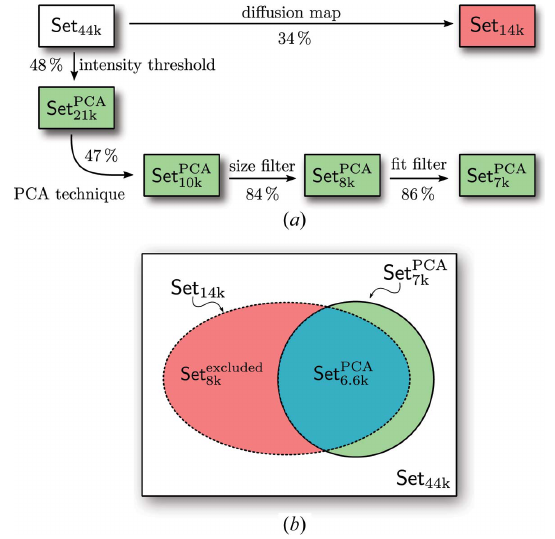
Figure 6 ( a ) Data workflow and filtering stages. The red box indicates the data selection provided by Reddy et al. (2017) and the green boxes show the selection from the PCA technique. ( b ) Schematic of data set relations with the intersection shown in